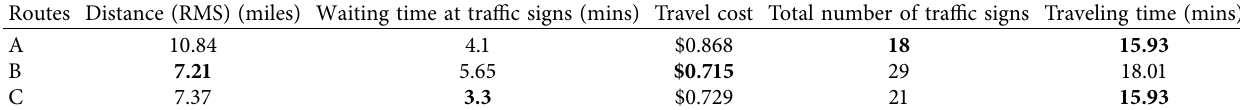
Table 2: Evaluation summary for routes A, B, and